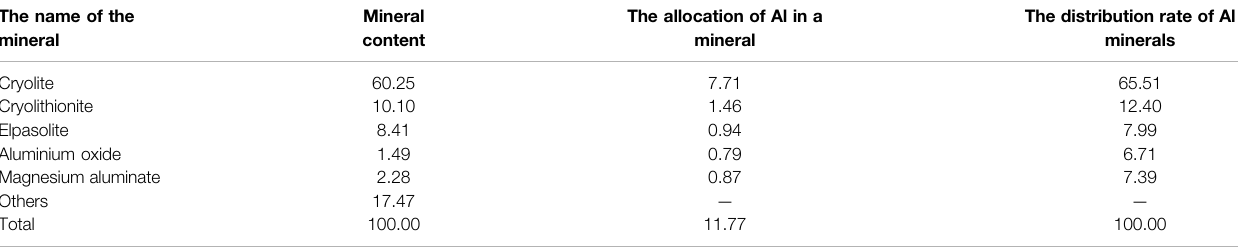
TABLE 5 | Calculation table of distribution rate of aluminum in aluminum-containing minerals/%. The name of the mineral